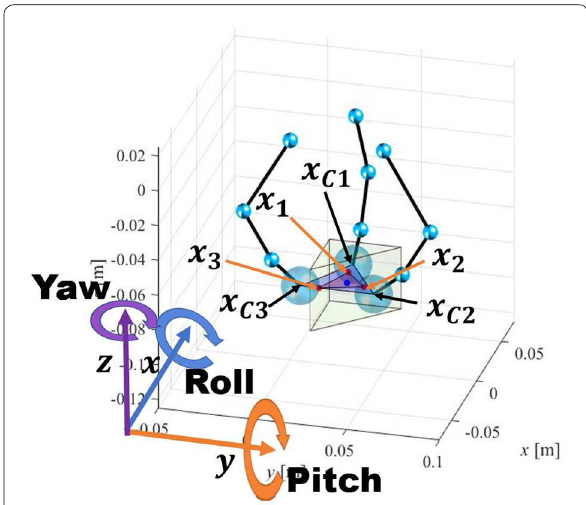
Fig. 16 Coordinates of a three‑fingered robotic hand and a grasped object used in the